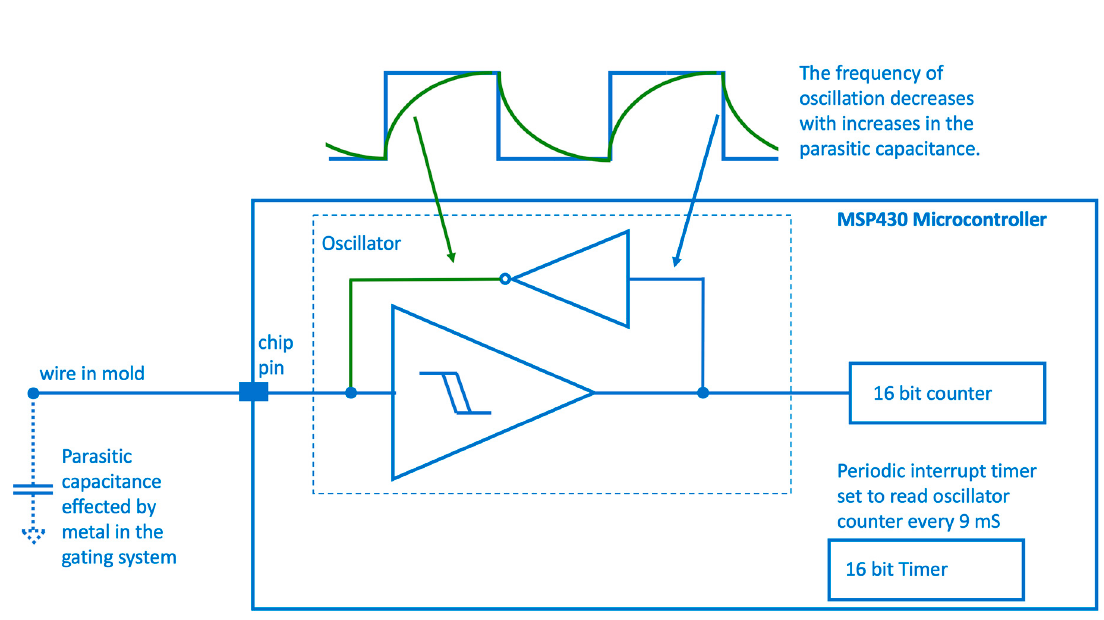
Figure 4. Circuit diagram for capacitive sensing using MSP430 microcontroller [56].